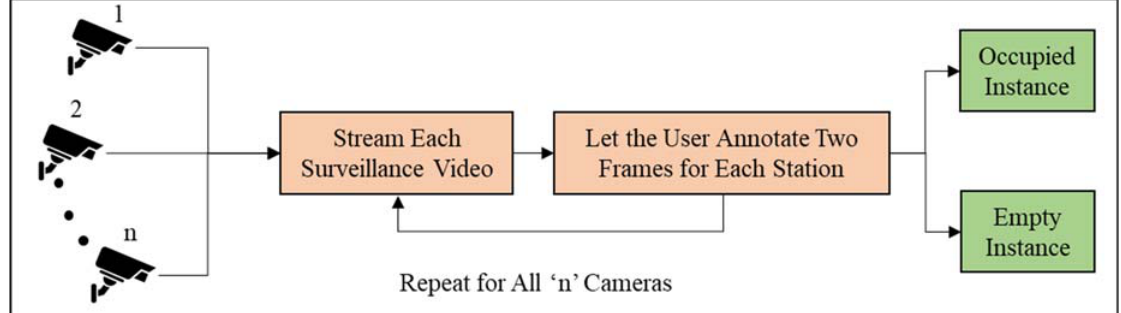
Figure 2. Manual annotation pipeline.